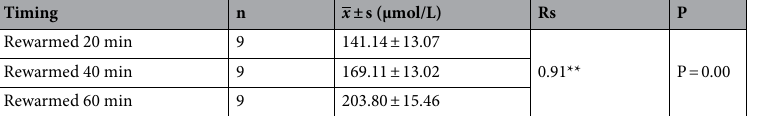
Table 3. Glu value of brain extracellular fluid in different rewarming time groups (μmol/L). There was a significant correlation between different rewarmed times and Glu values. **When the confidence (bilateral) is 0.01, the correlation is significant.